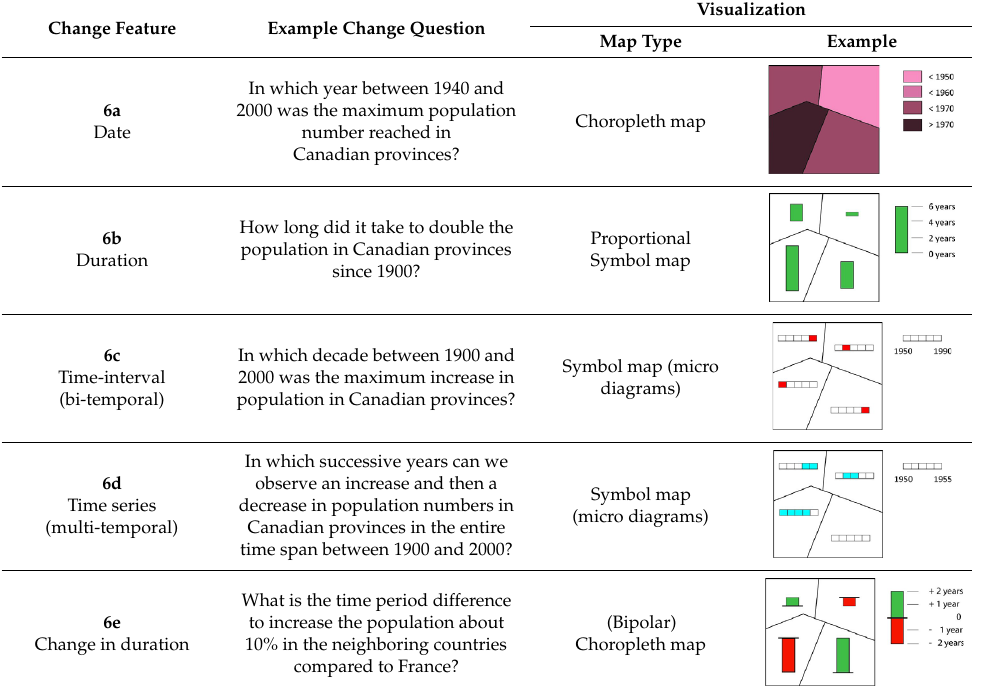
Table 6. Visualization of “When” output clauses (compare classification in Table 3). Change